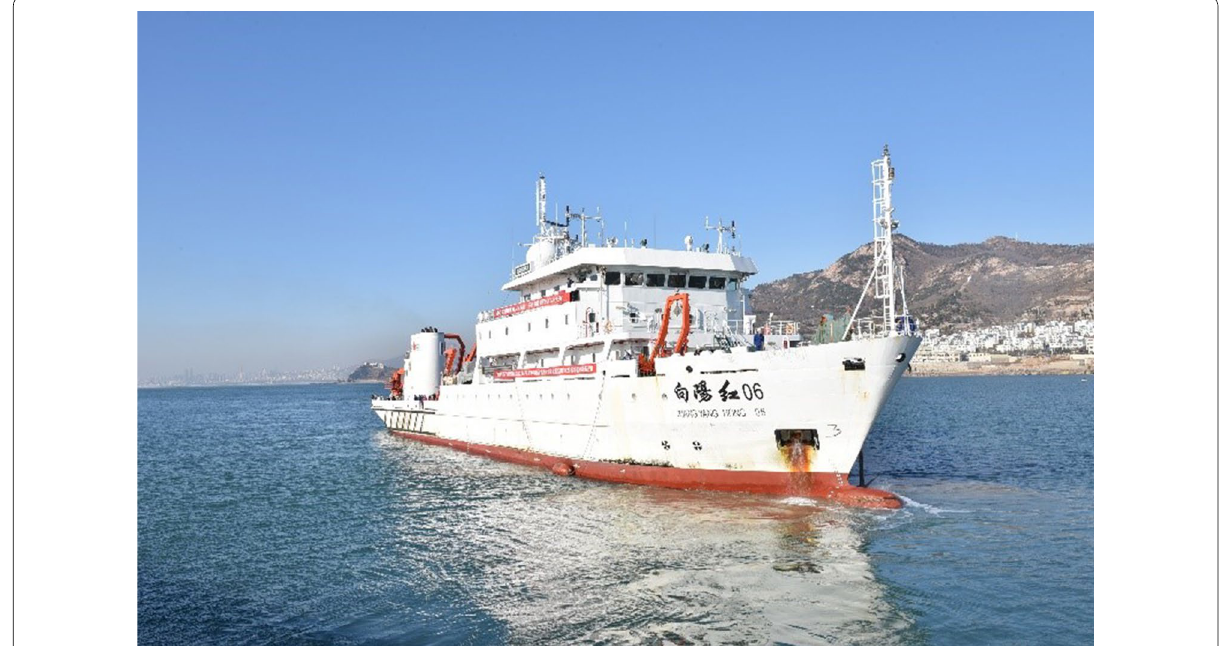
Fig. 2 Survey carrier: Xiangyanghong No. 06